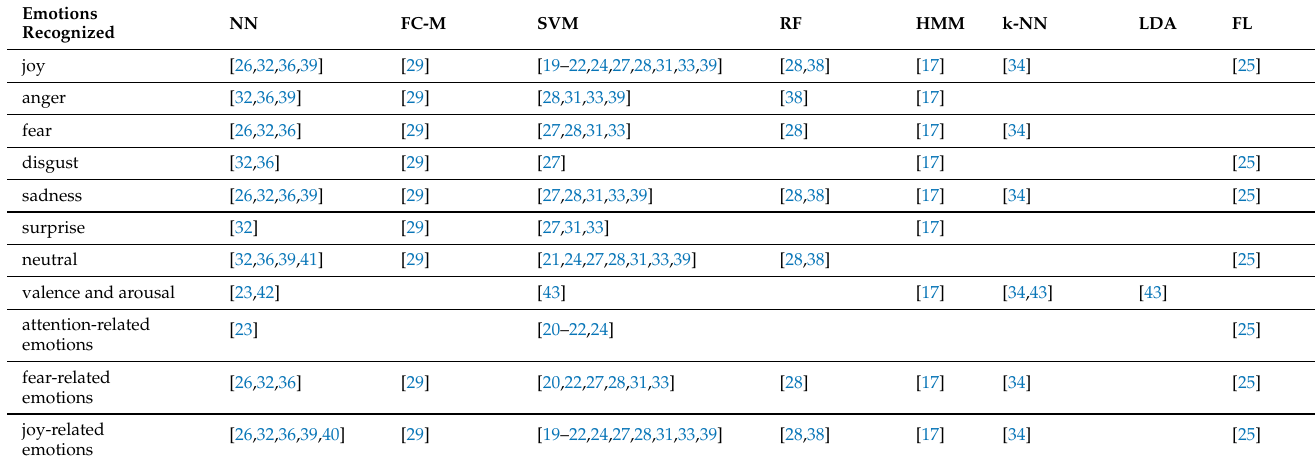
Table 8. Recognized emotions and group of emotions corresponding to machine-learning techniques.